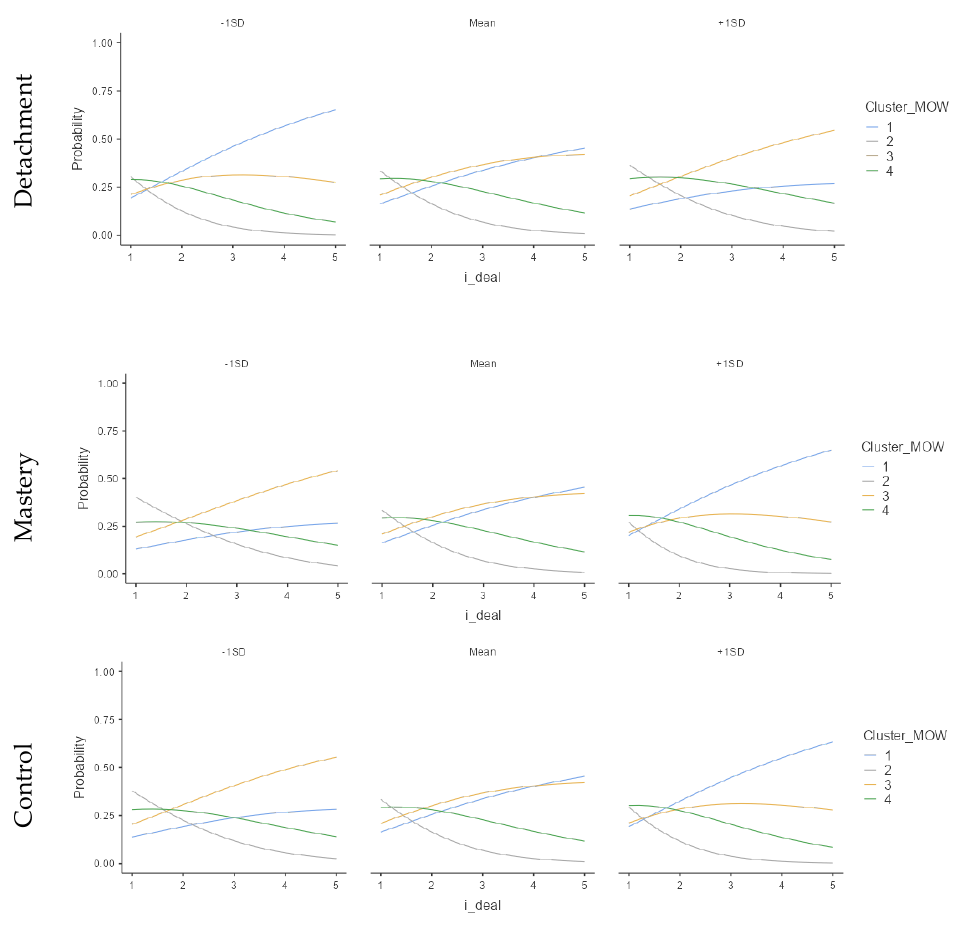
Figure 6. Recovery and Flexibility i-deal interaction related to Meaning of Work and Job Perfor- mance clusters. Cluster 1: happy-productive; Cluster 2: unhappy-productive; Cluster 3: unhappy- unproductive; Cluster 4: happy-unproductive. (Study 1; N = 386).